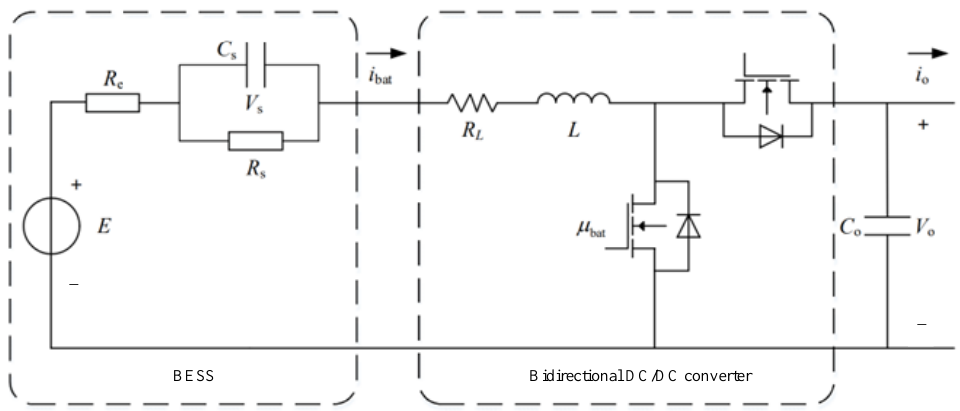
Figure 3. Equivalent circuit diagram of battery energy storage system and bidirectional DC/DC buck–boost converter.